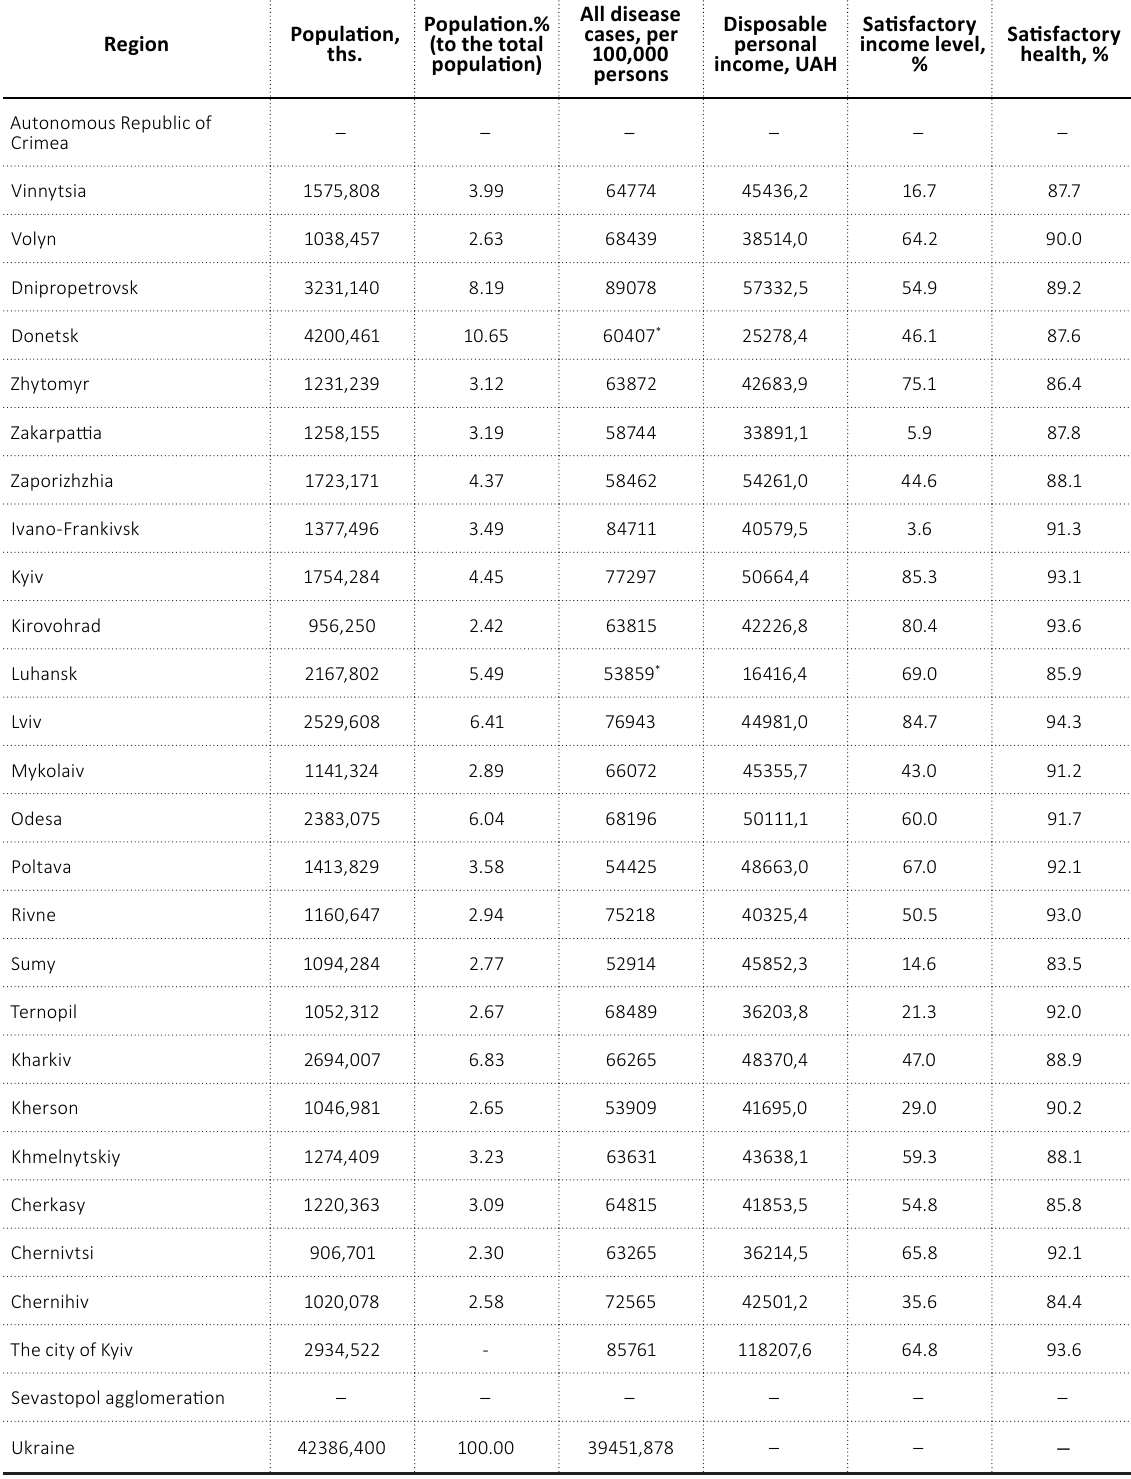
Table A1. Absolute and relative income and health indicators, by regions of Ukraine, 2017 Source: Calculated by the authors on the basis of data of State Statistics Service of Ukraine from site ukrstat.gov.ua Region Population,